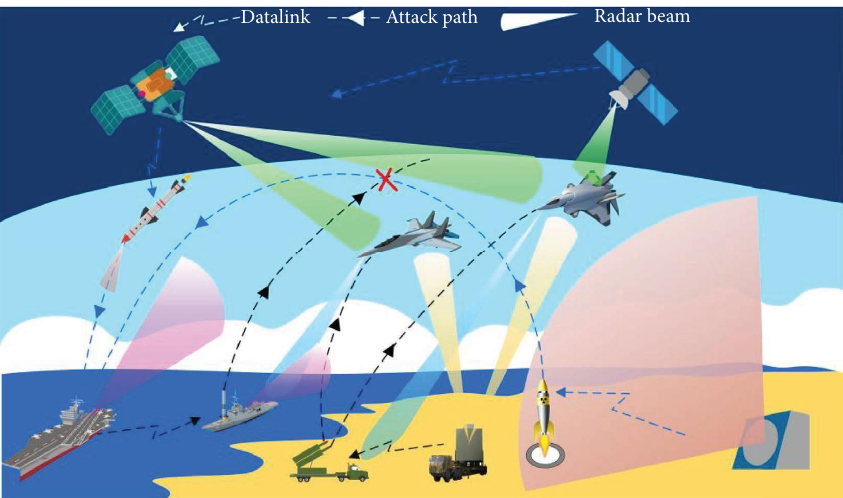
Figure 2: Five-dimensional modern war of sea, land, air, sky, and